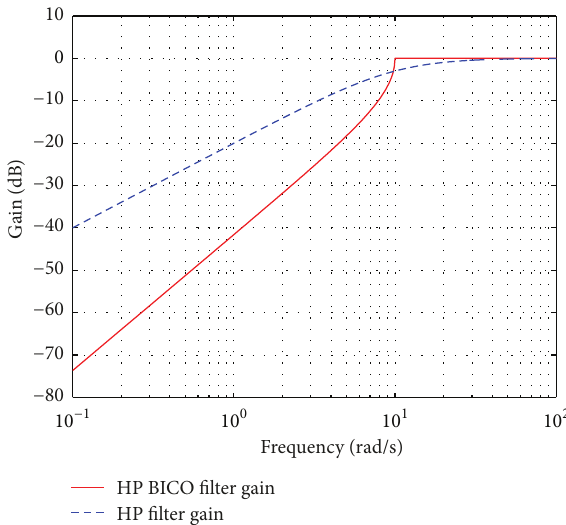
Figure 6: High-pass BICO and regular high-pass